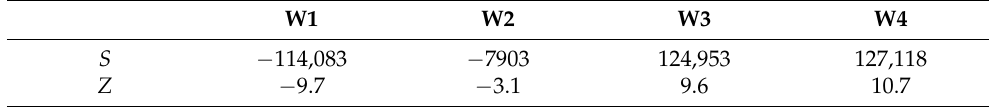
Table 2. Test results of the Mann–Kendall trend analysis.